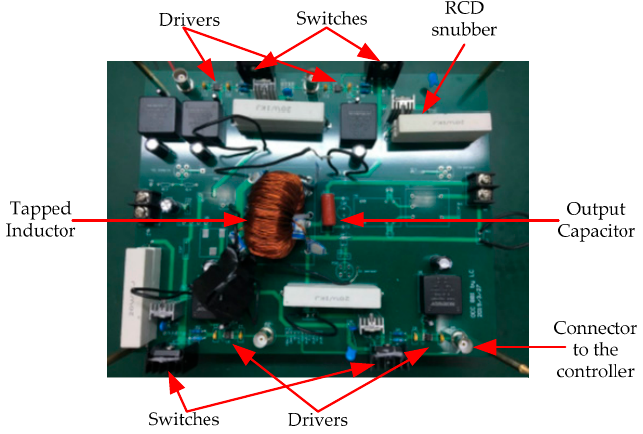
Figure 10. Photo of the experimental prototype of the proposed